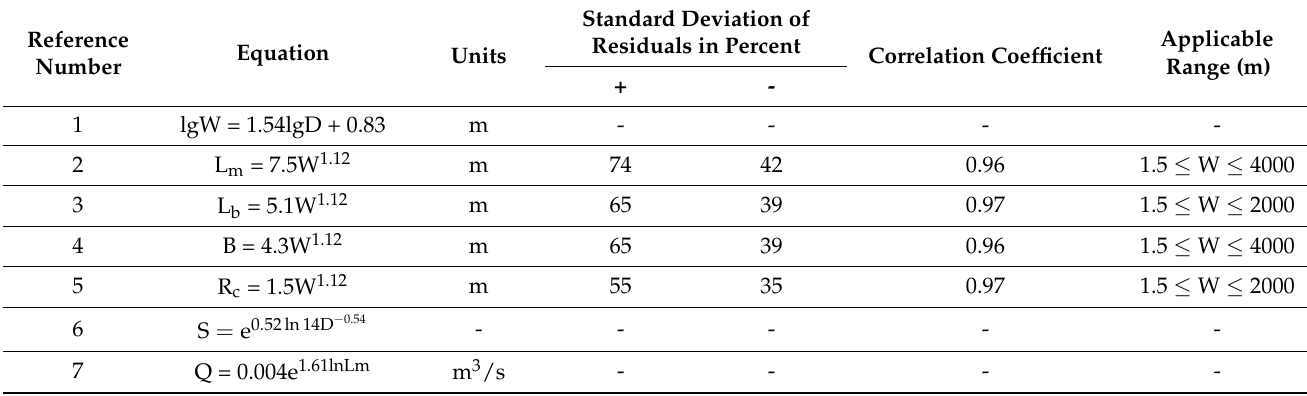
Table 1. Empirical equations of estimation of quantitative parameters for meandering